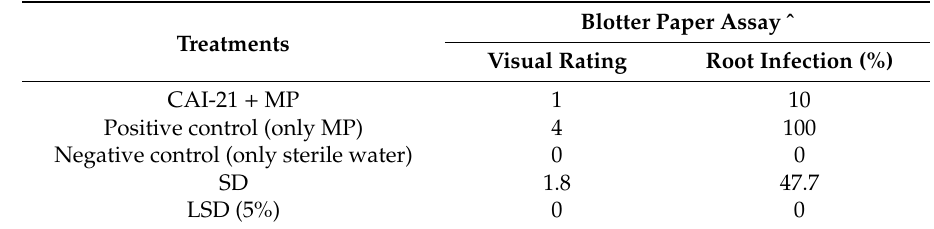
Table 2. Evaluation of S. albus CAI-21 for its biocontrol potential against charcoal rot of sorghum— blotter paper assay .